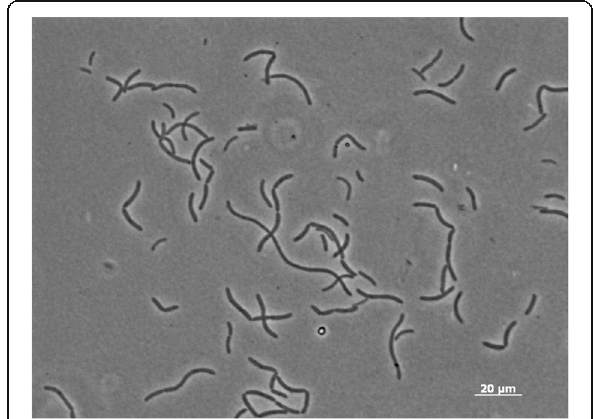
Fig. 1 Photomicrograph of cells of Effusibacillus lacus strain skLN1 T . Cells were grown on aerobic R2A liquid medium at 50 °C for 1